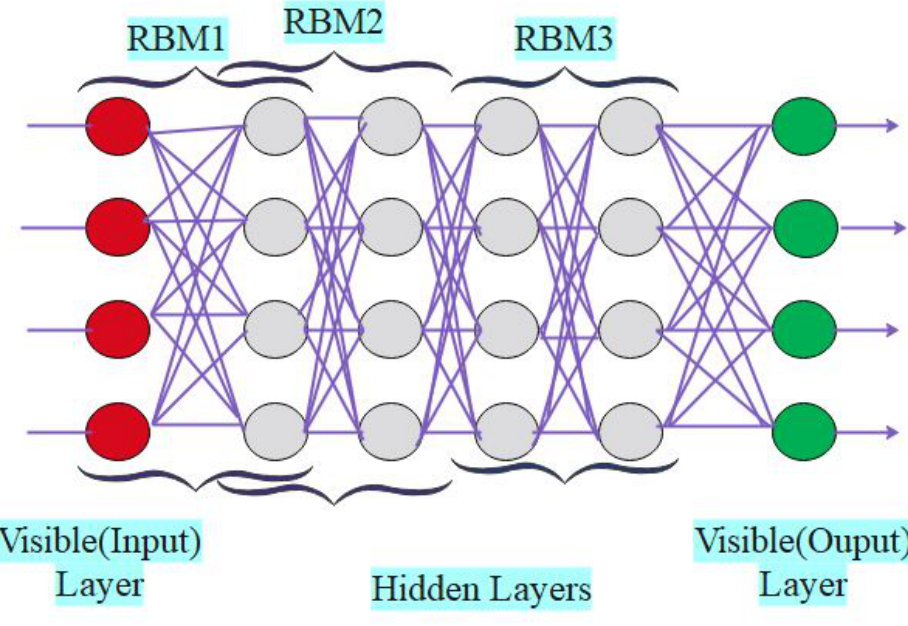
Figure 9. The Structure of Deep Belief Networks